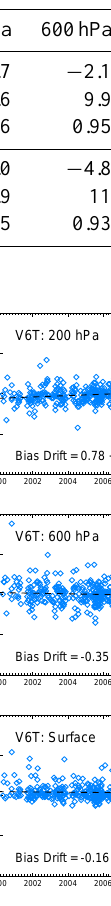
Figure 7. Time series plot showing V6 TIR-only (V6T) bias trends based on NOAA